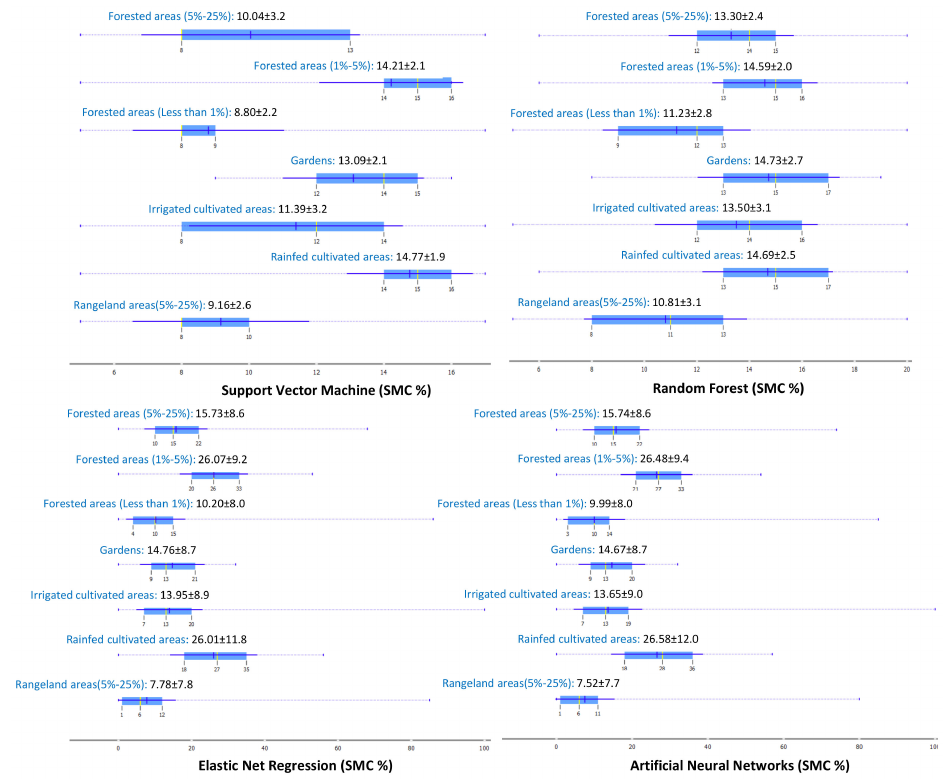
Figure 4. Box plot of SMC models with columns split by ‘landuse’ on 7 March 2017. X -axis represents SMC (unit %). Box plots represent sample medians (yellow vertical line), mean (the dark blue vertical line), border values for the standard deviation of the mean, the blue highlighted area is the entire standard deviation of the mean, the thin blue line represents the area between the first (25%) and the third (75%) quantile, while the thin dotted line represents the entire range of values (from the lowest to the highest value in the data set for the SMC).